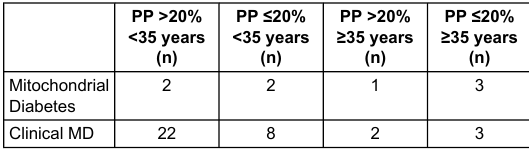
Table S1: Probability for MODY each patient with mitochondrial dia- betes and in the group with clinical diagnosis.